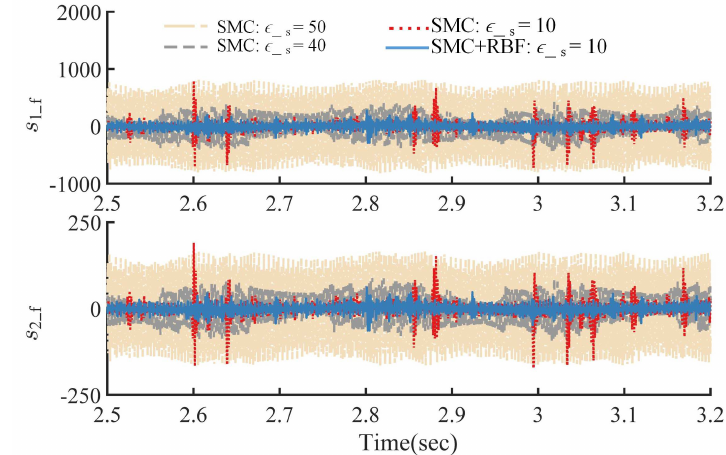
Figure 6. Time history of the fast sliding surface s _f .